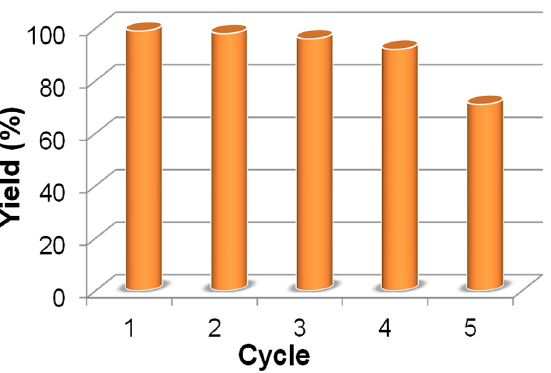
Figure 6. Recycling of Pd-NHC@Eu-BCI for Suzuki–Miyaura coupling reactions. Reaction conditions: bromobenzene (1.0 mmol), phenylboronic acid (1.2 mmol), K 2 CO 3 (2.0 mmol), ethanol (5 mL), temperature (80 o C).